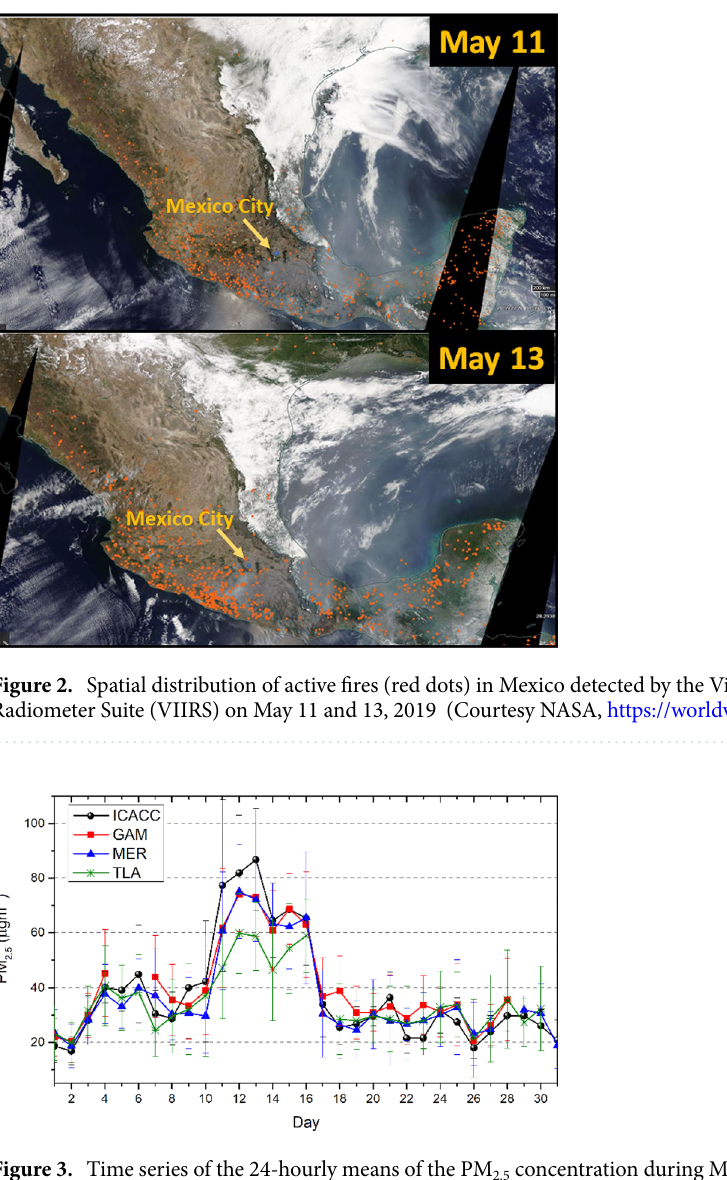
Figure 3. Time series of the 24-hourly means of the PM 2.5 concentration during May 2019. Data were plotted for the four RAMA stations: ICACC (black), GAM (red), MER (blue), and TLA